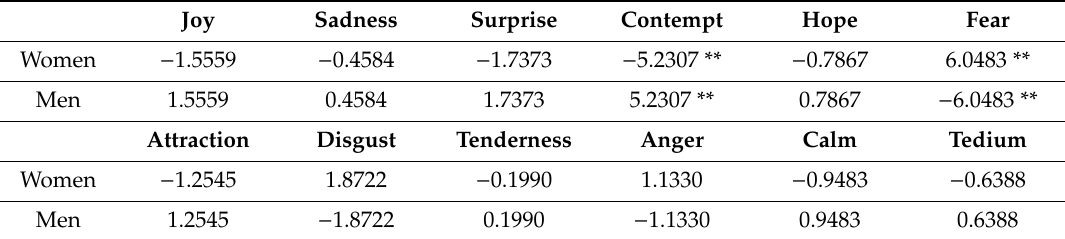
Table 7. Pearson standardized residual values (Z-factor) between the discrete emotion reported and gender. Joy Sadness Surprise Contempt Hope